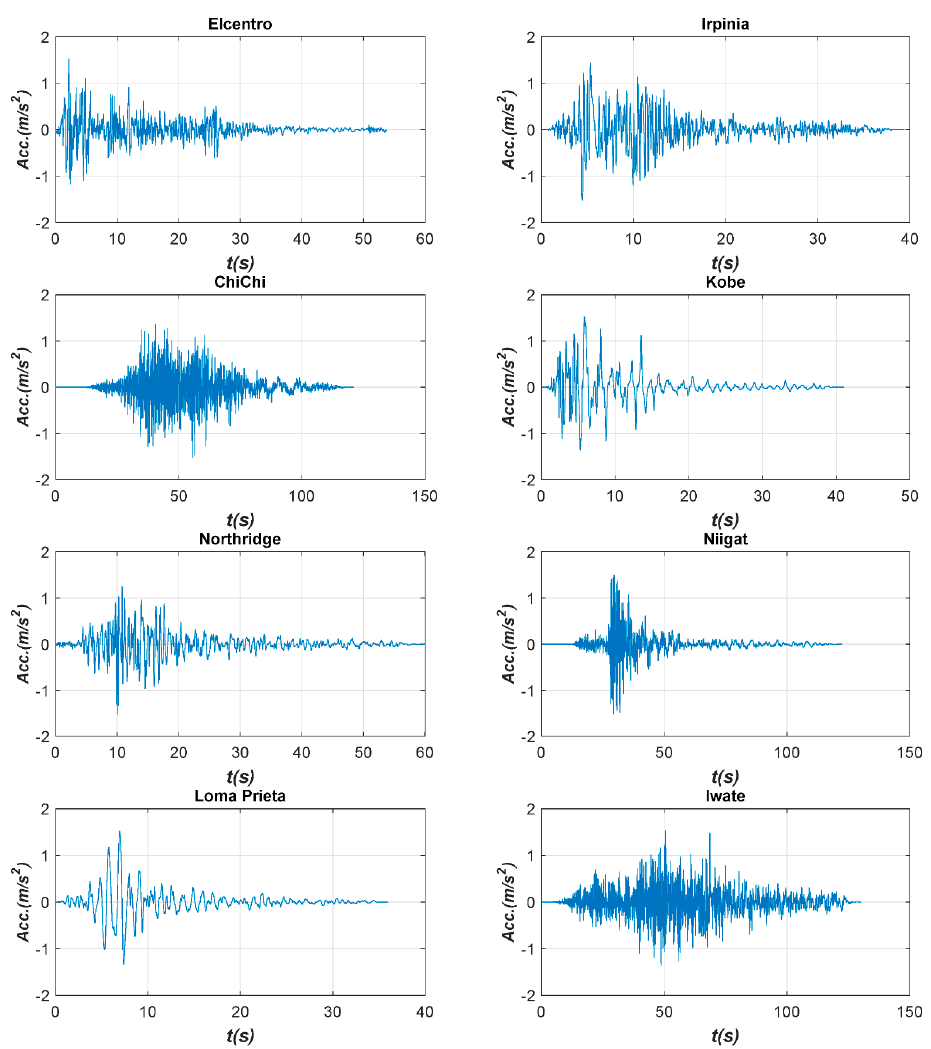
Figure 7. Time histories of ground motions.